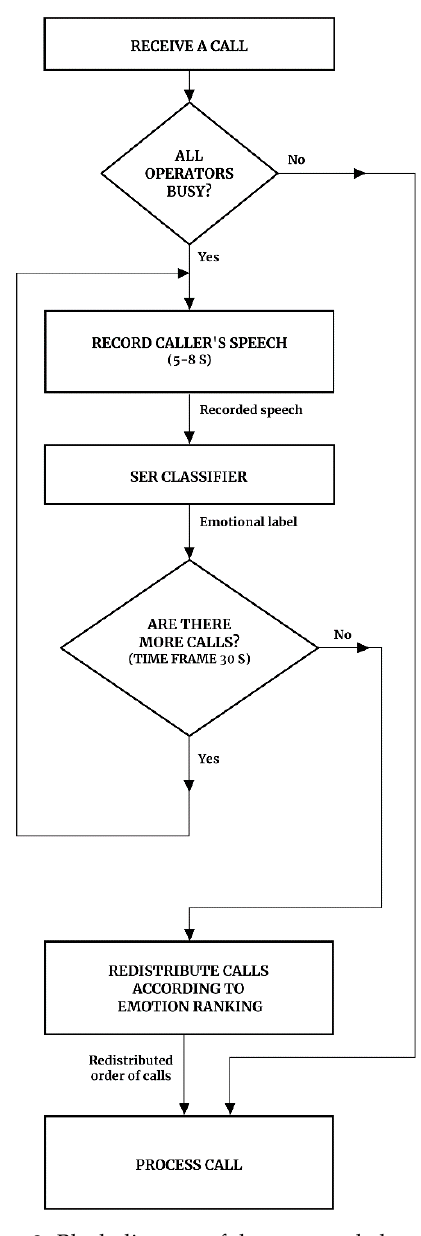
Figure 3. Block diagram of the proposed algorithm.